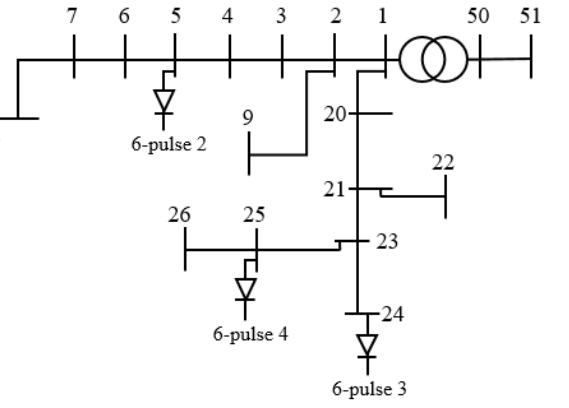
Figure 14. Single-line diagram of the 18-bus IEEE test network containing 3 nonlinear loads.